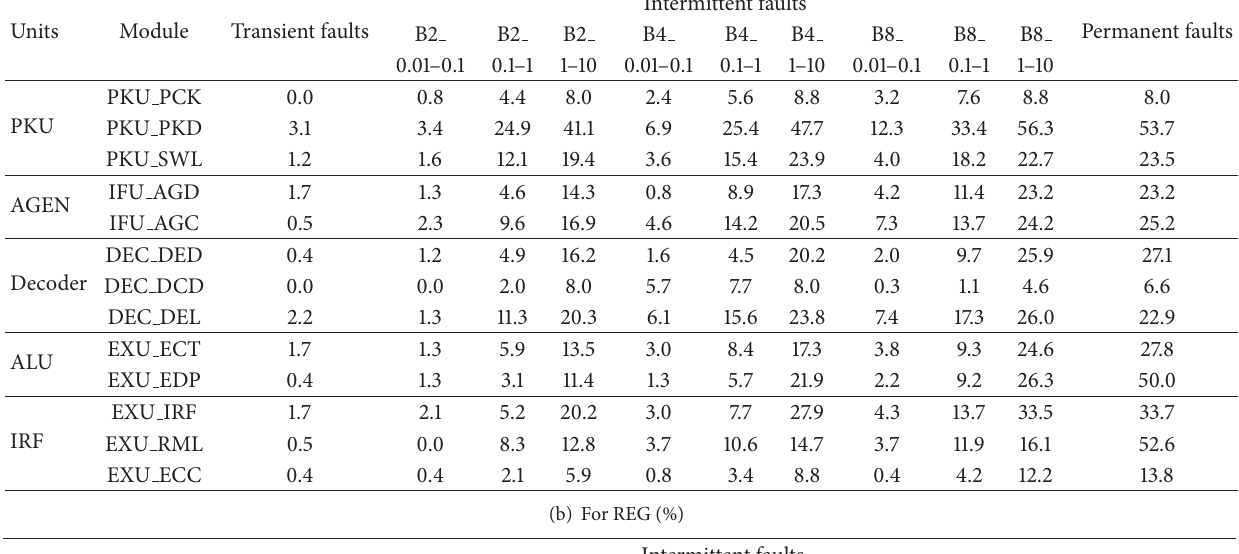
Table 5: Sensitivity breakup per unit for EXU workload ((a) for NET and (b) for REG). (a) For NET